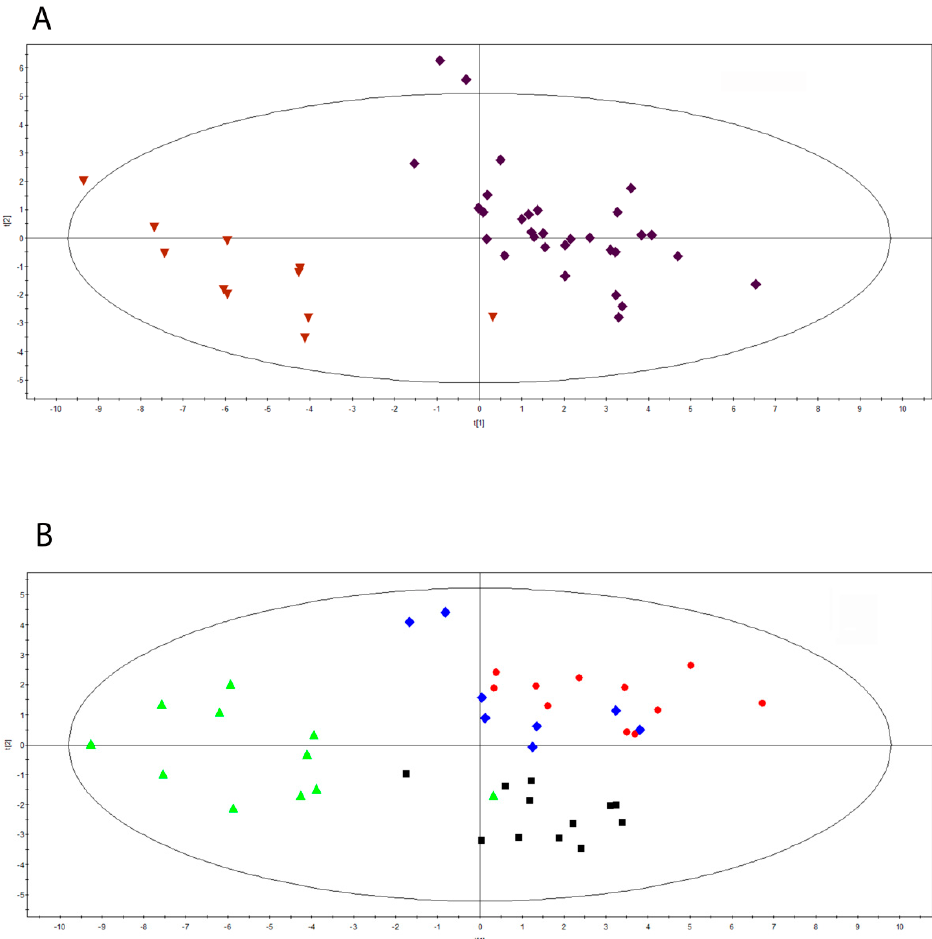
Figure 1. ( A ) Scores scatter plot calculated on two components by using 42 observation of 12 MuS cases, divided into two time groups: during pregnancy and post-partum. The classification is based on each metabolite concentration, excluding steroids and estrogens. The Partial Least Squares Discriminant Analysis (PLS-DA) was used to classify sera from MuS patients in each time group as follow: purple diamonds: during pregnancy; dark red inverted triangles: post-partum obtained by R2Y = 0.865 and Q2(cum) = 0.758. ( B ) Scores scatter plot calculated on two components by using 42 observations divided into three different times of pregnancy and the post-partum period. classification is based on each metabolite concentration, excluding steroids and estrogens. The Partial PLS-DA was used to classify sera from MuS patients in each time group as follow: black boxes: first trimester of pregnancy; red dots: second trimester of pregnancy; blue diamonds: third trimester of pregnancy; green triangles: post-partum obtained by R2Y = 0.484 and Q2(cum) = 0.321.